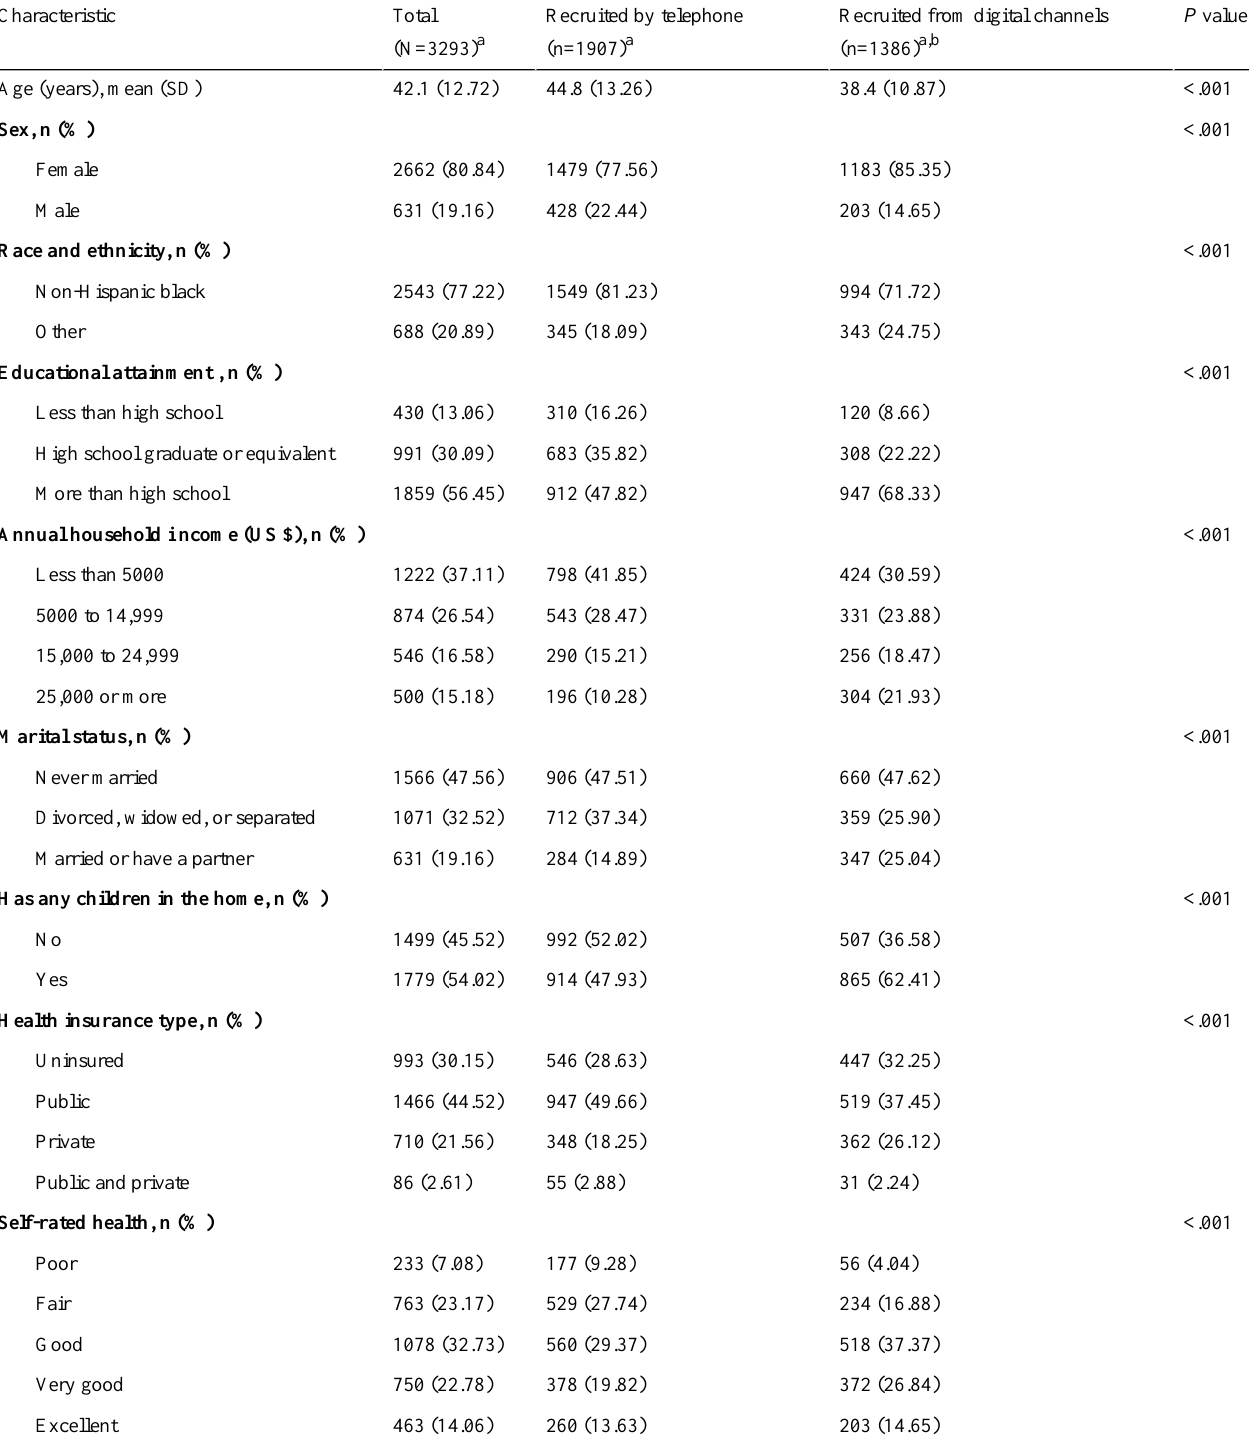
Table 1. Characteristics of Cancer Communication Channels in Context Study participants by recruitment channel type.